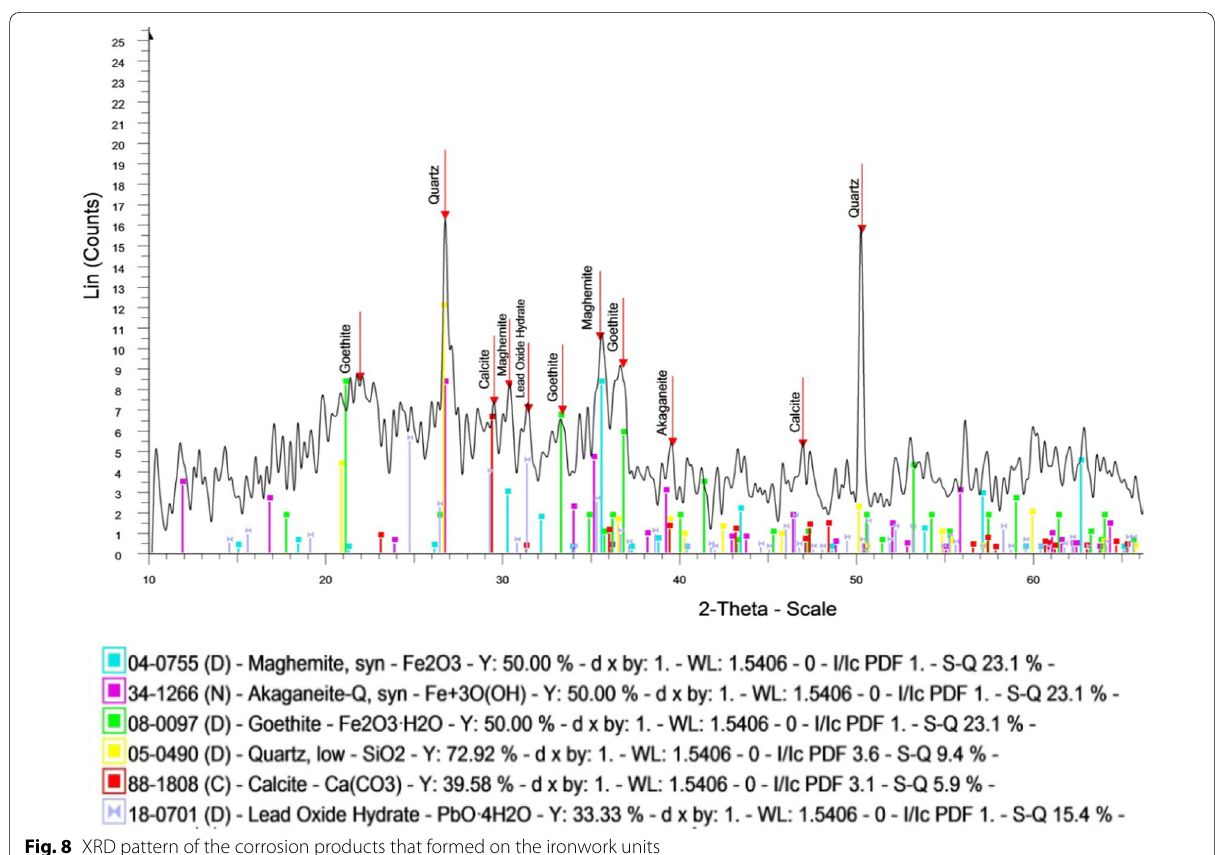
Fig. 8 XRD pattern of the corrosion products that formed on the ironwork units